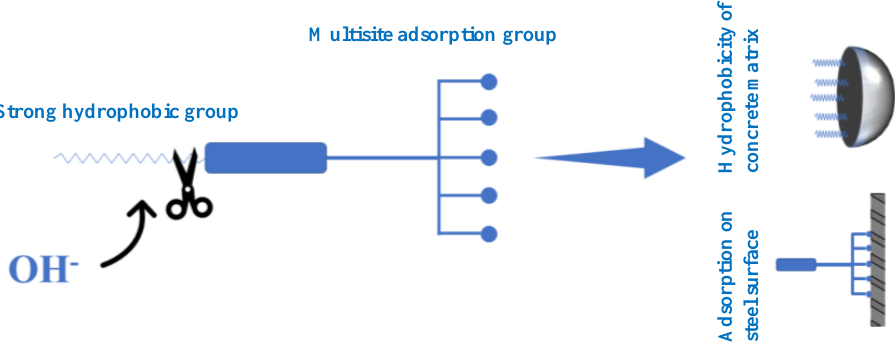
Figure 1. The schematic diagram of hydrophobic functional organic corrosion inhibitor.